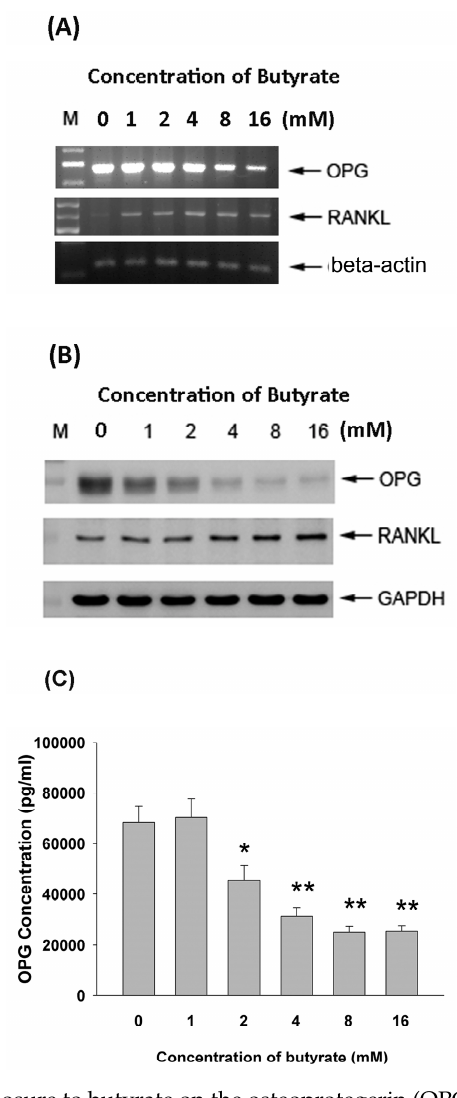
Figure 5. Effect of 24-h exposure to butyrate on the osteoprotegerin (OPG) and receptor activator of nuclear factor kappa-B ligand (RANKL) expression of MG63 osteoblastic cells. ( A ) RT-PCR analysis of mRNA expression, ( B ) Western blot analysis of OPG and RANKL protein expression, ( C ) ELISA analysis of OPG level in culture medium. Statistically significant differences are denoted by * and ** ( p < 0.05 and p < 0.01) when compared with the control, respectively.